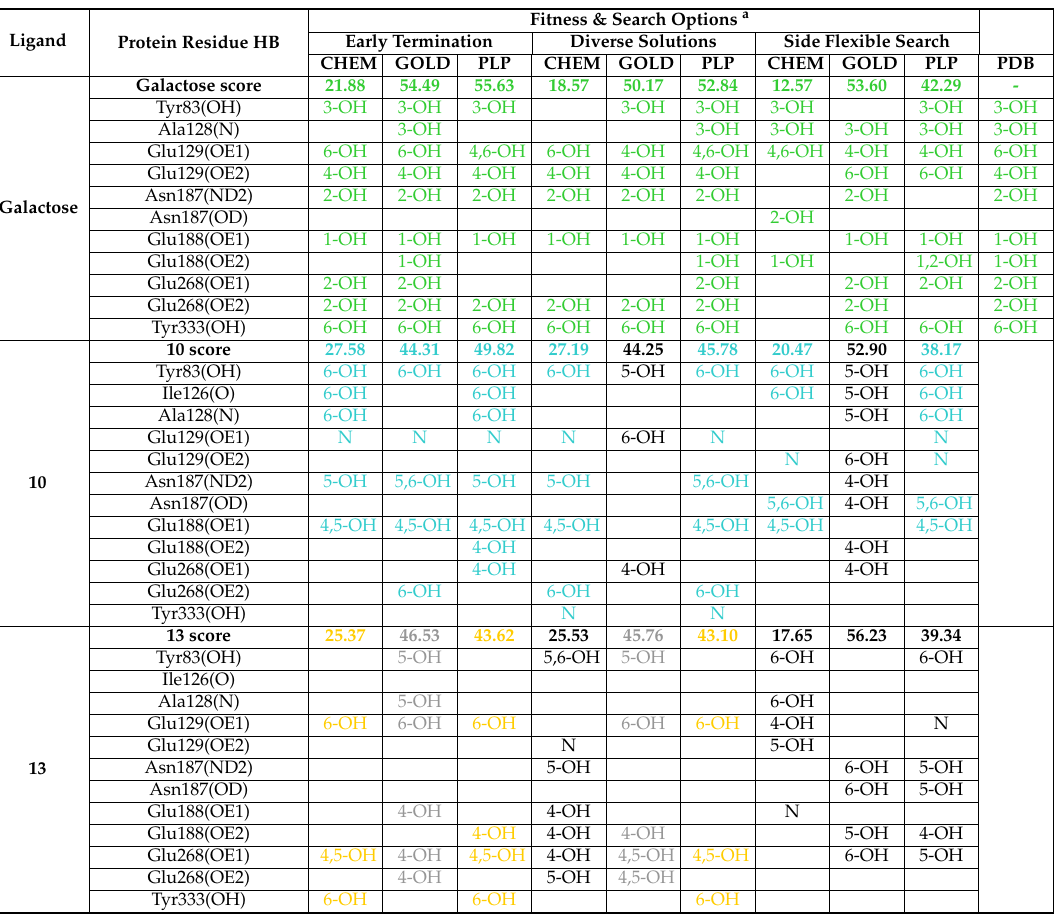
Table 2. Results of the docking simulations and score values for the top pose of each run. Ligand